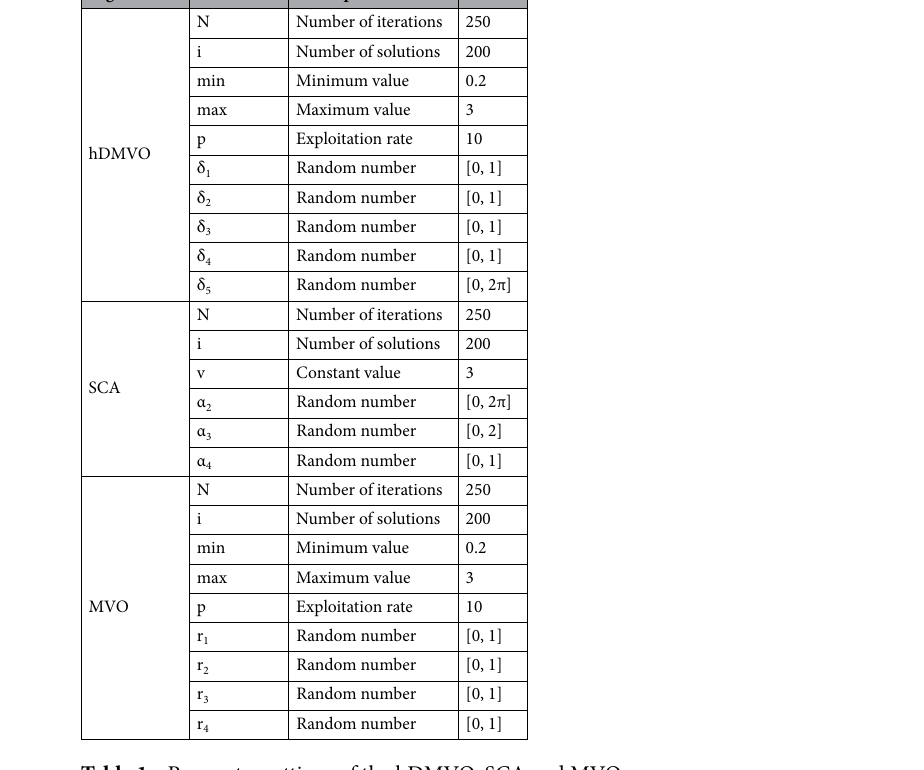
Table 1. Parameter settings of the hDMVO, SCA and MVO.